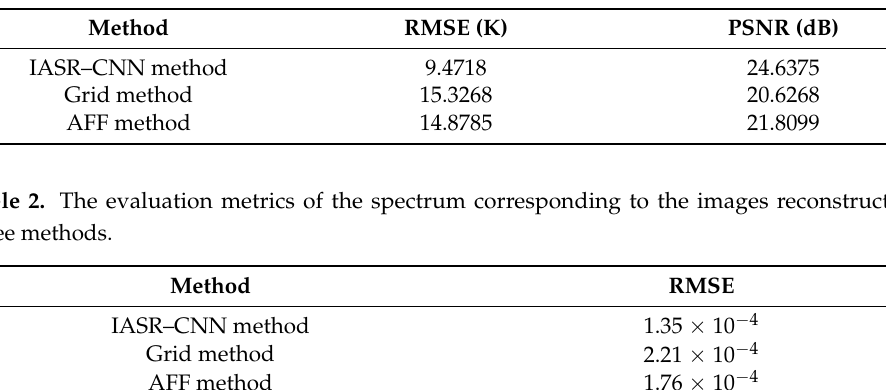
Table 1. The evaluation metrics of the brightness temperature images reconstructed by three methods.